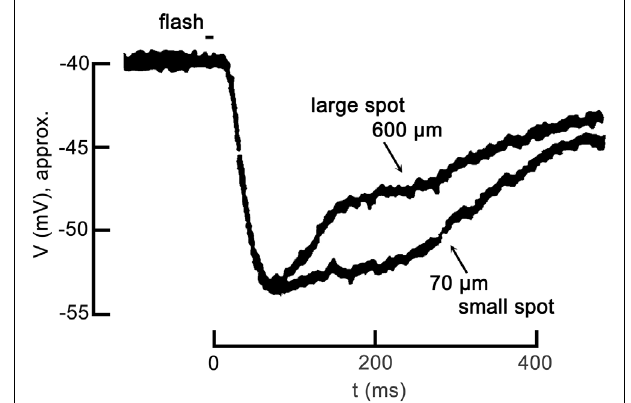
FIGURE 1 | Center-surround antagonism in a cone photoreceptor due to feedback. The voltage response of a turtle cone to a small spot of light (70 µ m diameter) and the response to a large spot (600 µ m diameter) follow identical hyperpolarizing trajectories at the onset, but diverge during recovery. Both responses are plotted relative to the dark resting membrane potential of about − 40 mV. The large spot response undergoes a pronounced inhibitory phase starting about 100 ms post-stimulus, becoming relatively more depolarized more quickly than the small spot response. The large spot recruited the receptive field surround of the cone via the large broad field of a horizontal cell, which feedback to the cone antagonizing the center response. Figure modified from Baylor et al.